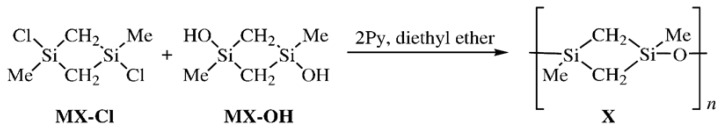
Synthesis of CL PMCS X.